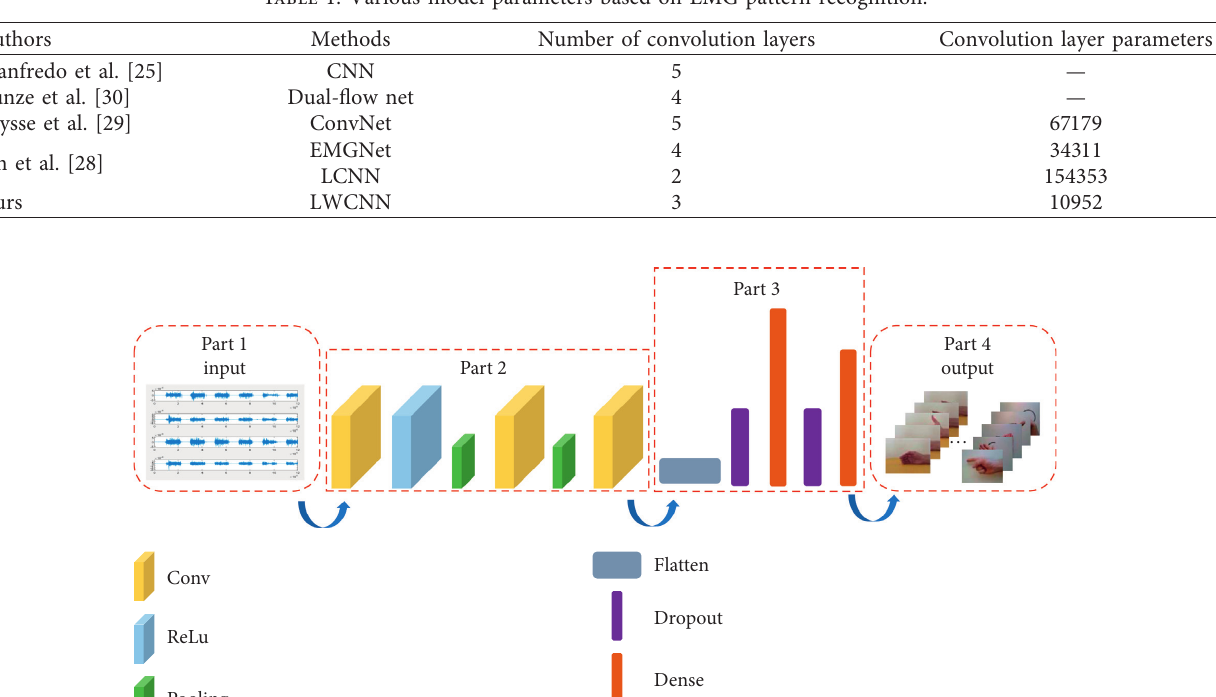
Figure 2: Network structure of the